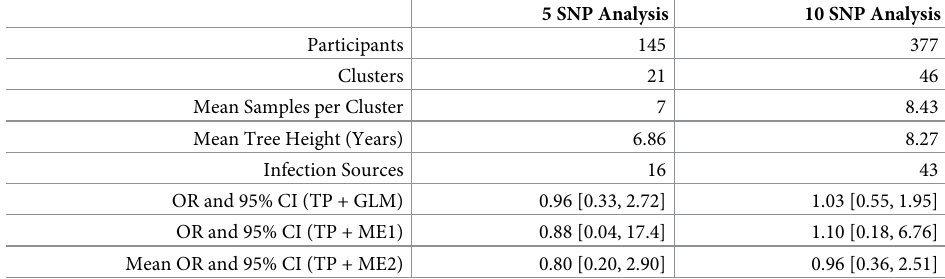
Table 3. Summary of analyses using five and ten SNP cutoffs. Summary of analyses using five and ten SNP cutoffs. Mean tree height refers to the height of timed phylogenetic trees in years. TP + GLM refers to a statistical pipeline where infection source labels are first generated using TransPhylo and then used as response variables in a general- ized linear model to calculate an odds ratio. The odds ratio is the odds ratio for the probability of being an infection source given the case is living without HIV as compared to cases living with